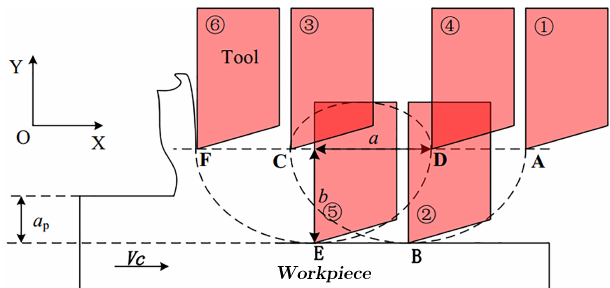
Figure 1. Principle of 2-D EVC.